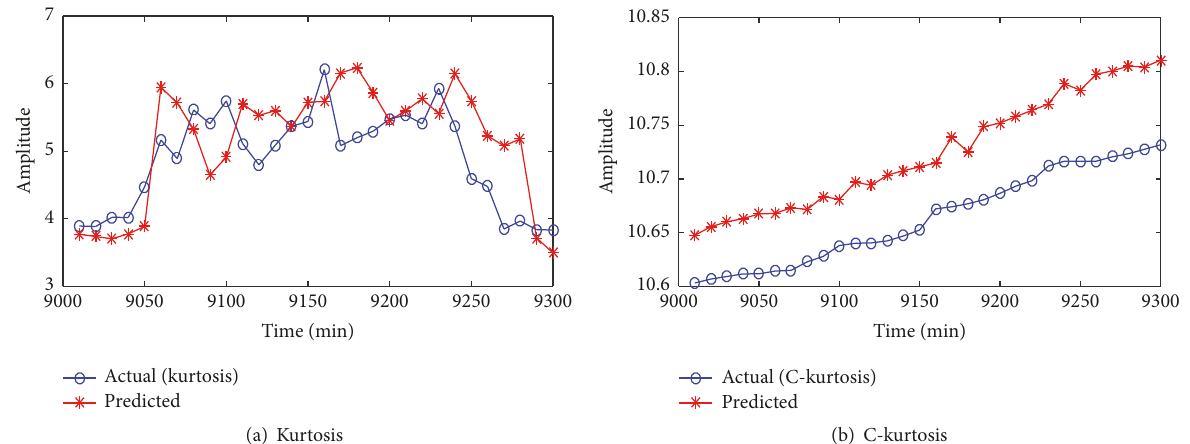
Figure 15: Prediction results of kurtosis and C-kurtosis.